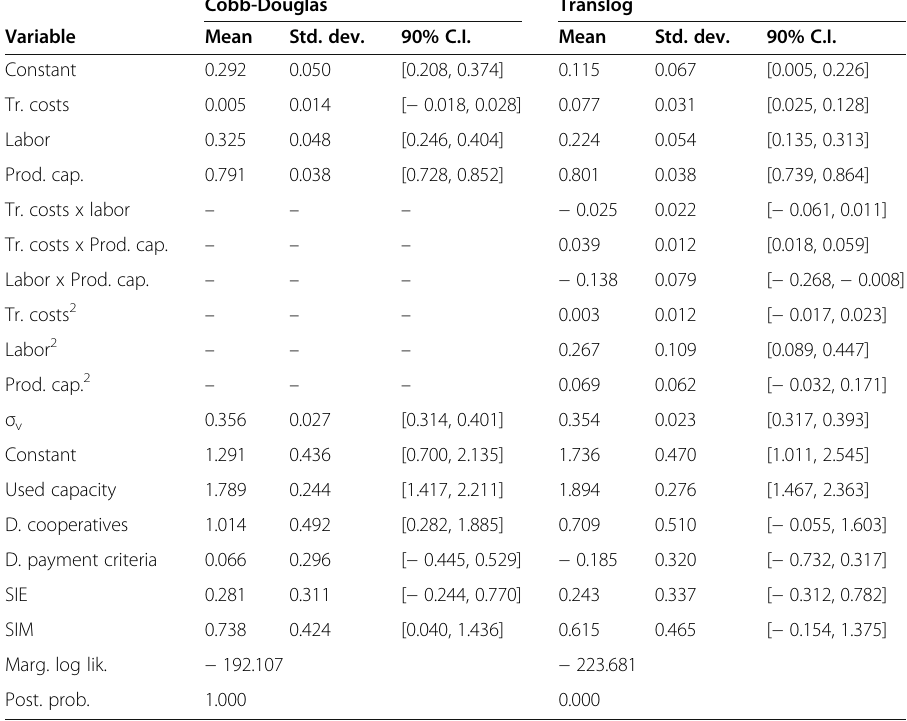
Table 6 Results from the Cobb-Douglas and translog specifications